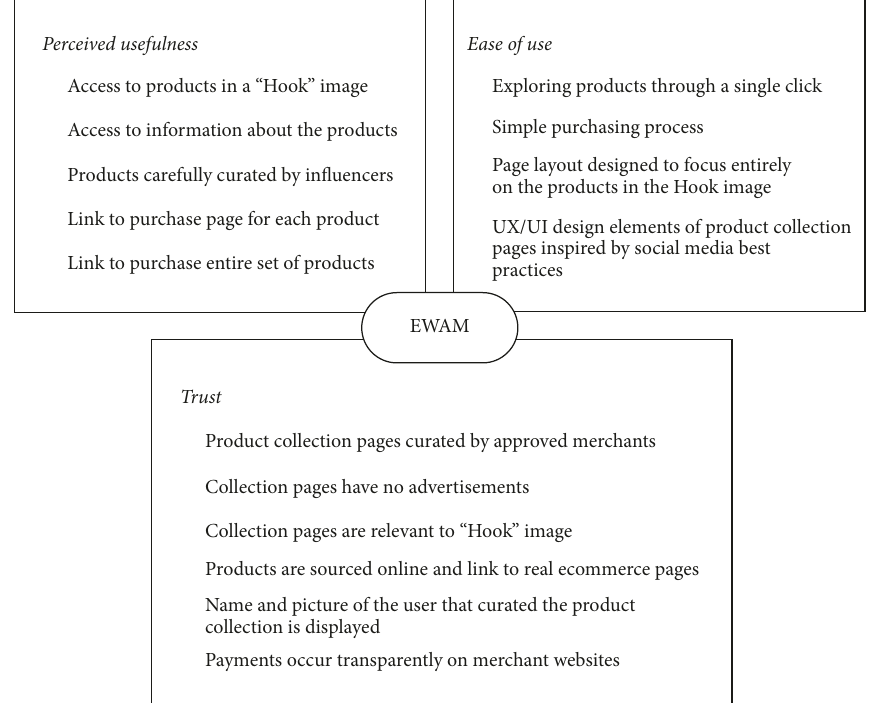
Figure 1: The application of the extended web assessment method criteria in the development of the DoBundle tool.